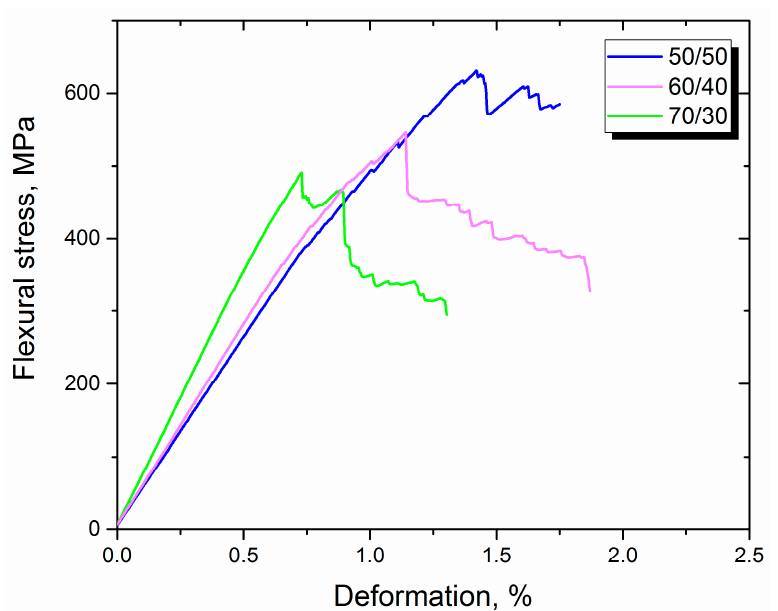
Figure 6. Typical stress–strain curves of composites reinforced with initial CF with different fiber content.